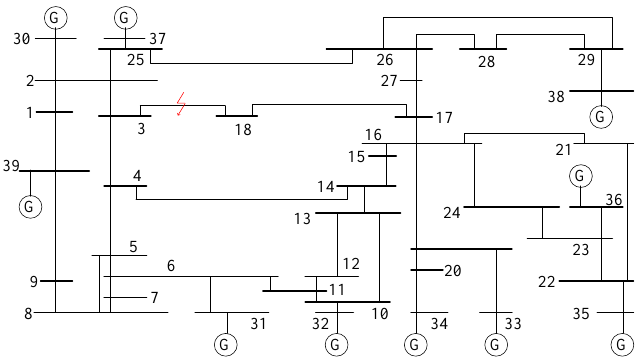
Figure 10. Single fault of the IEEE 39-bus system.